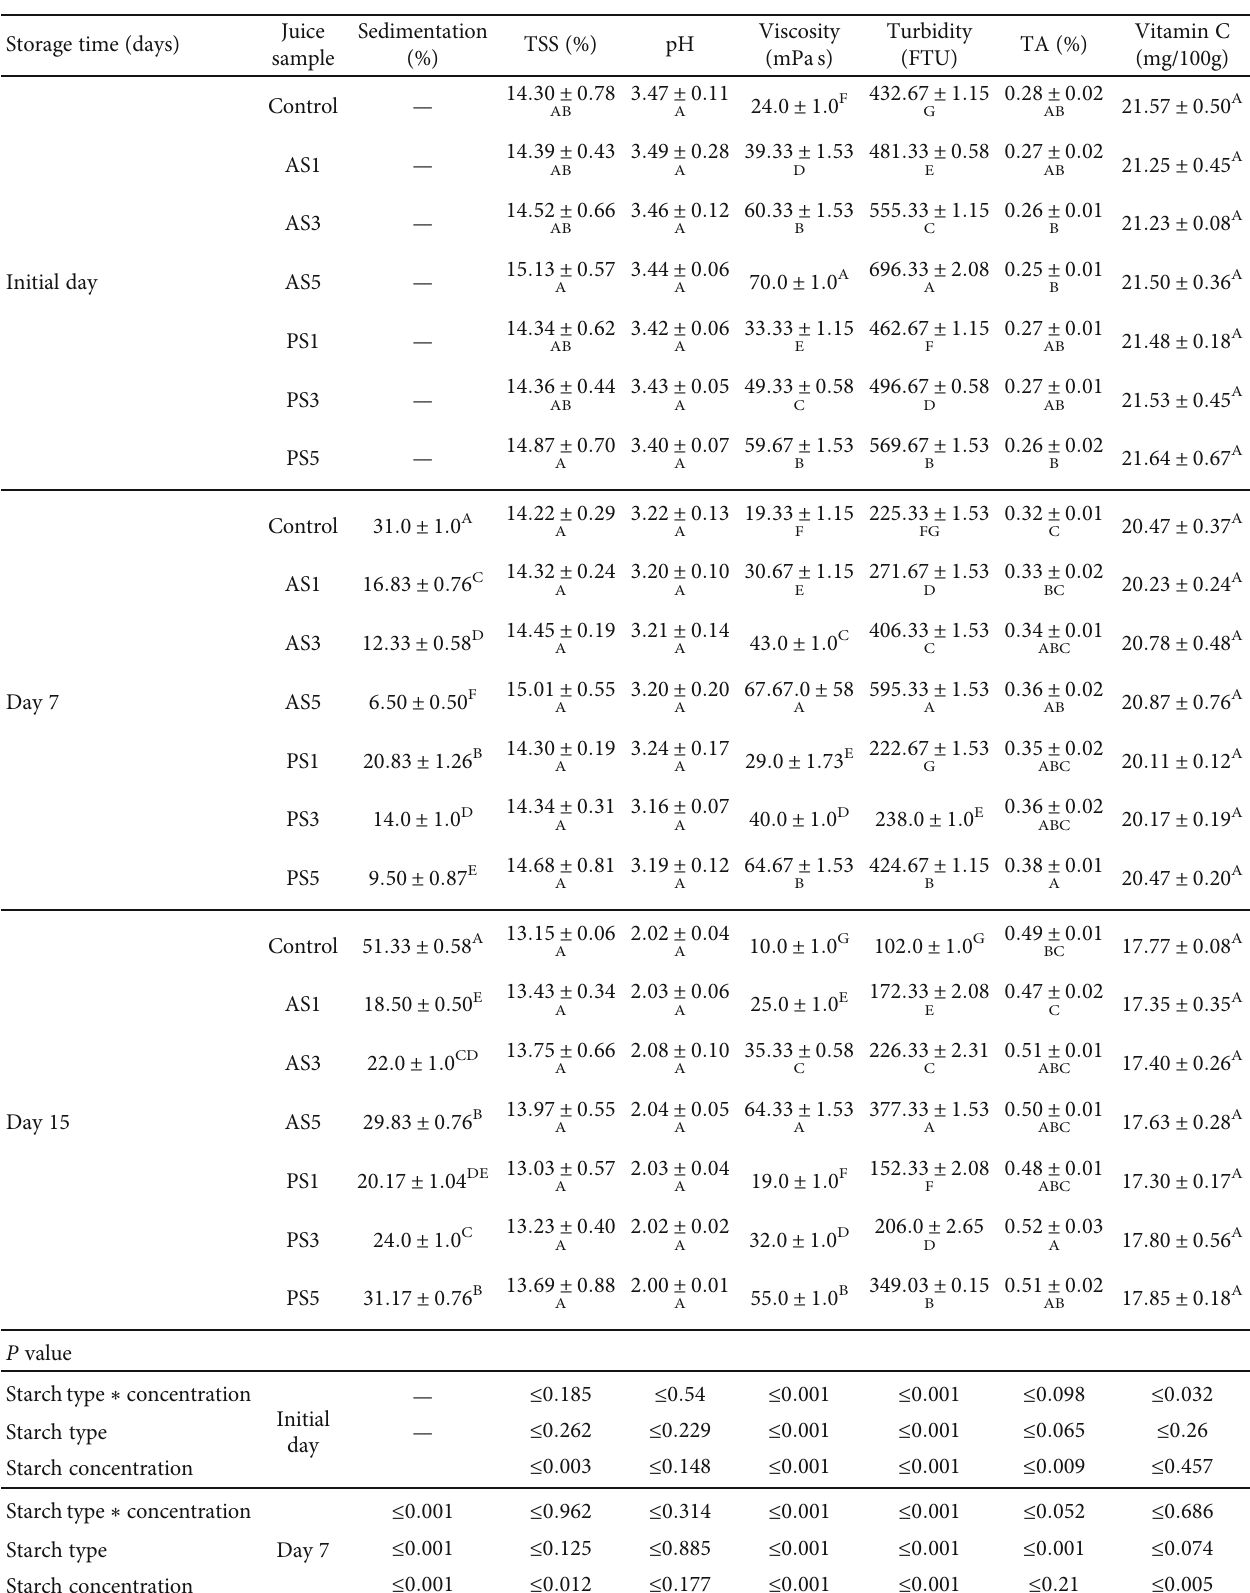
Table 3: Physicochemical properties of pineapple juice samples added with di ff erent types of starch with di ff erent concentrations stored for 15